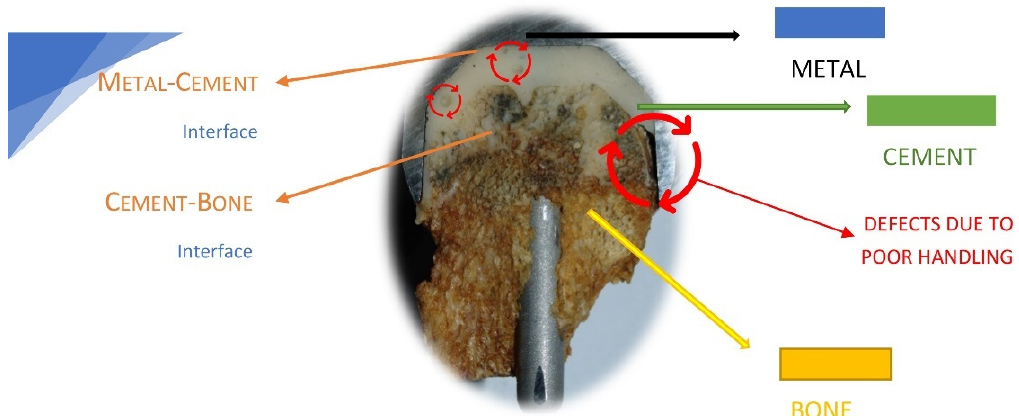
Figure 2. Schematic presentation of implant–cement and cement–bone interfaces.